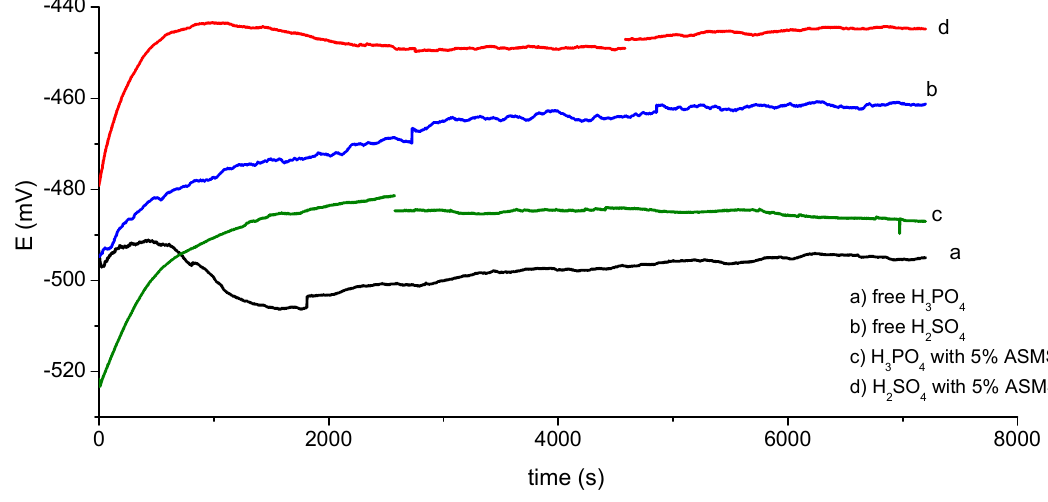
Figure 5. The potential–time curve for different solutions for two hours at 298 °K.